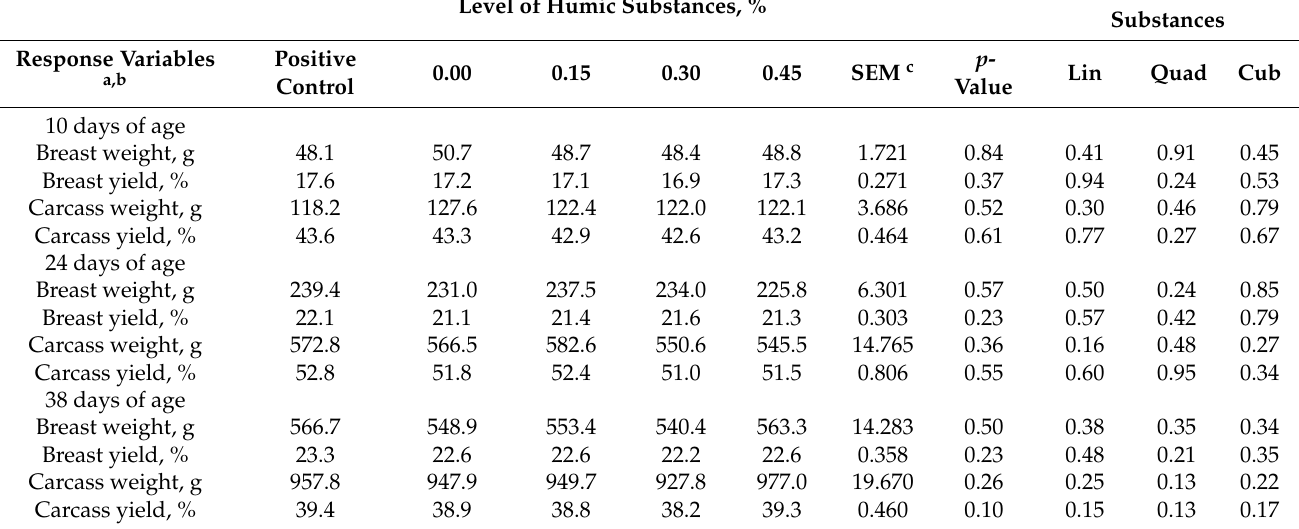
Table 3. Breast and carcass weight and yield of broilers added with increasing levels of humic substances in the feed, probability level, and type of effect associated with humic substances.